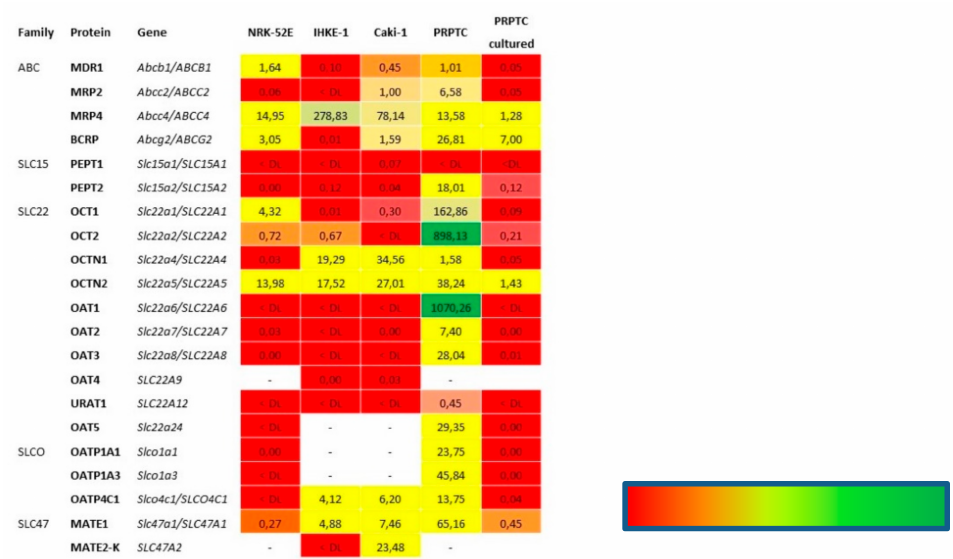
Figure 11. mRNA expression levels of transporters in cell lines normalized to GAPDH/Gapdh expression ( n = 3). < DL = below detection level, red= low expression intensity, green = high expression